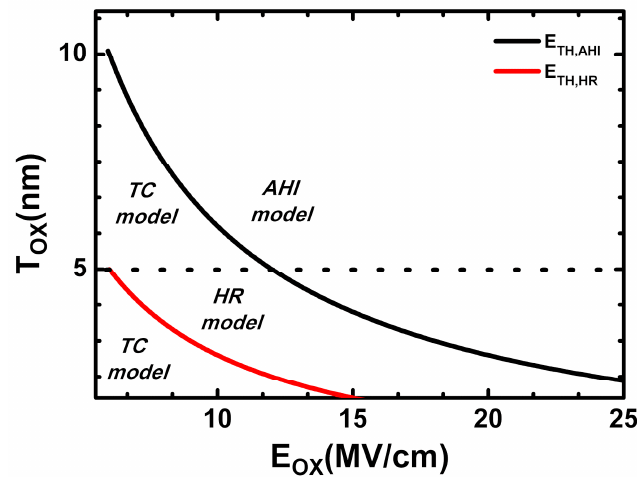
Figure 1. Time-dependent dielectric breakdown (TDDB) model which changes with oxide electric field Figure 1. Time - dependent dielectric breakdown (TDDB) model which changes with oxide electric ( E ox ) and oxide thickness ( T ox field ( 𝐸 (cid:3042)(cid:3051) ) and oxide thickness ( 𝑇 (cid:3042)(cid:3051) ).